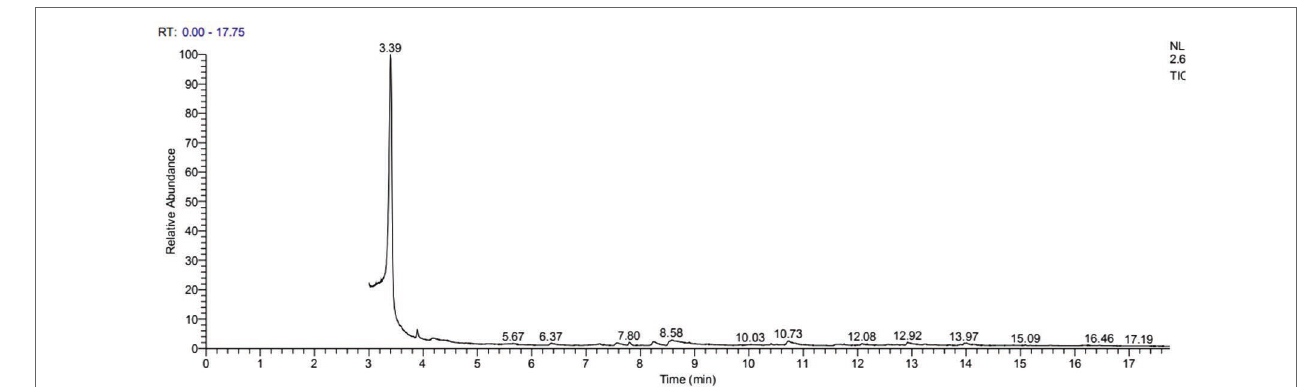
FIGURE 9 | Spectrum of 2,3-butanediol identification by GC-MS in the fermentation broth of R. aquatilis